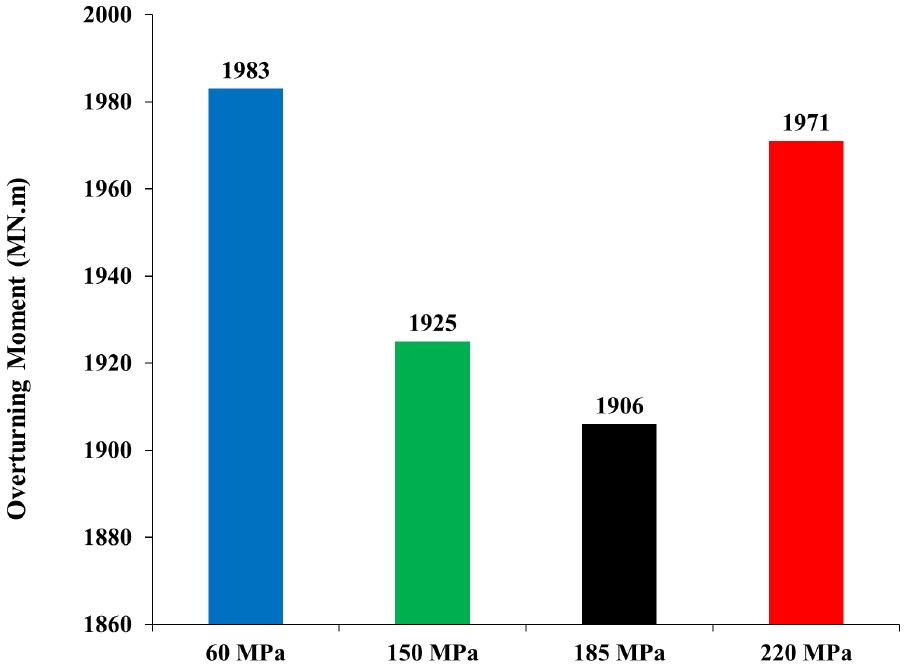
Figure 4. Overturning moment.